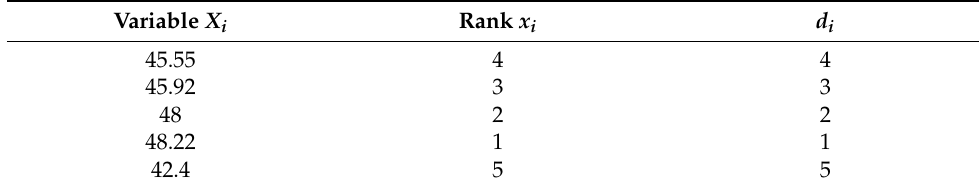
Table 5. Example for Spearman’s ρ